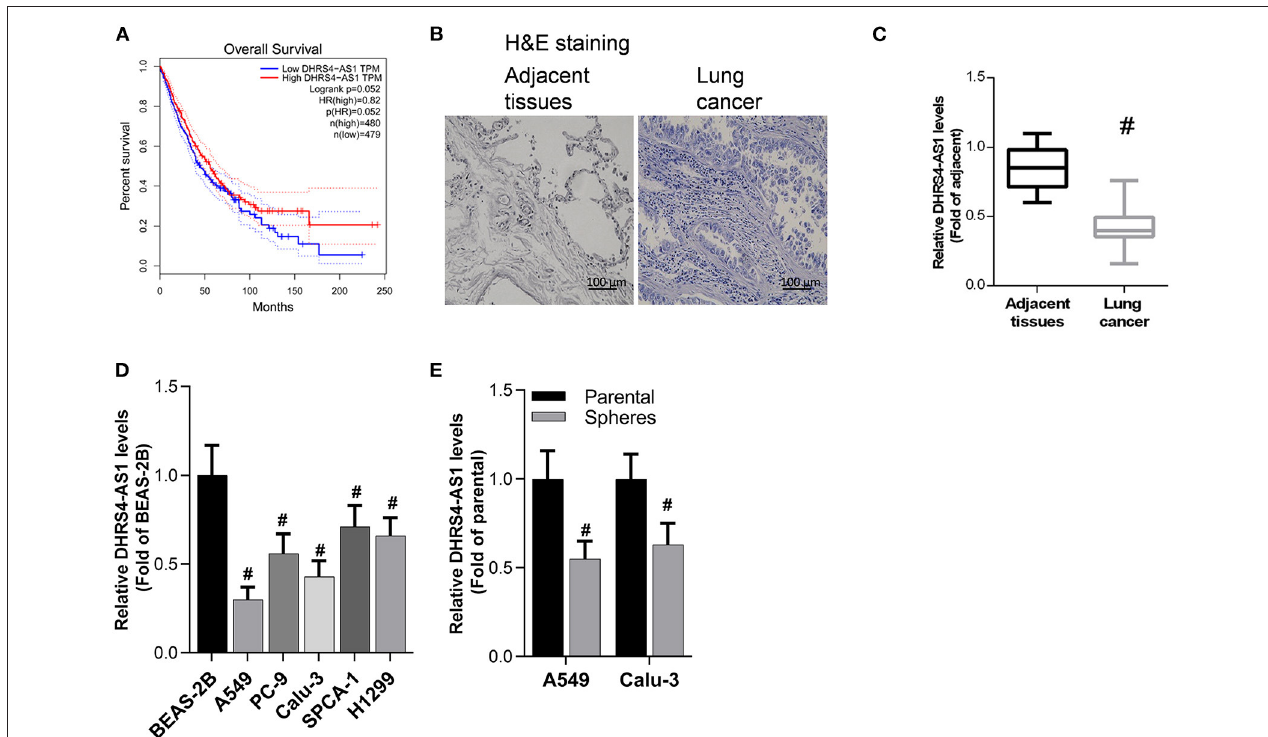
FIGURE 1 | Detection of DHRS4-AS1 expression in NSCLC and its clinical significance. (A) The survival rate of NSCLC was analyzed on the GEPIA web portal by DHRS4-AS1 expression. (B) Histopathological pictures shown the adjacent normal and cancer tissues. (C) Real-time PCR analysis of DHRS4-AS1 expression in adjacent lung ( N = 83) and cancer ( N = 83) tissues; # p < 0.01 vs. adjacent tissues. (D) Real-time PCR analysis of DHRS4-AS1 expression in lung cancer cell lines and normal lung epithelial cell line; # p < 0.01 vs. BEAS-2B cells. (E) Real-time PCR analysis of DHRS4-AS1 expression in parental and sphere-forming A549 and Calu-3 cells; # p < 0.01 vs. parental cells. All the results are expressed as the mean ± SD from three independent experiments, and each sample was repeated in triplicate.